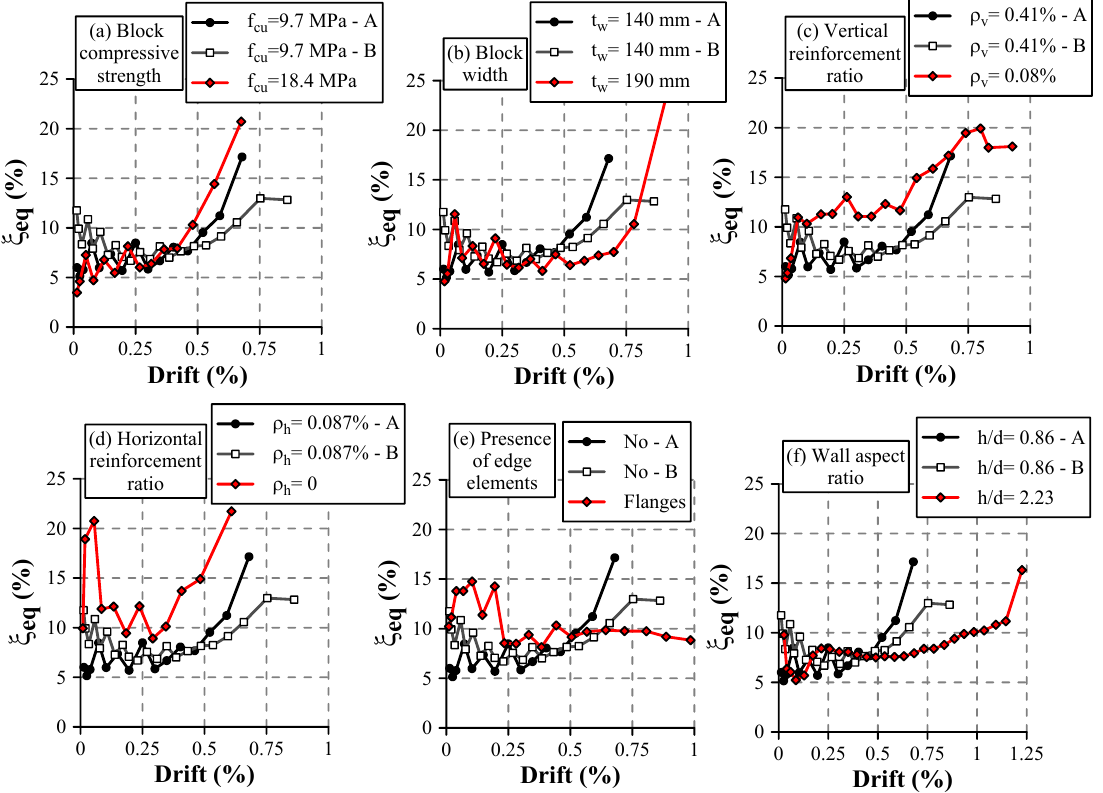
Figure 13. Effect of design parameters on the equivalent viscous damping: ( a ) block compressive strength, ( b ) block width, ( c ) vertical reinforcement ratio, ( d ) horizontal reinforcement ratio, ( e ) presence of edge elements, and ( f ) wall aspect